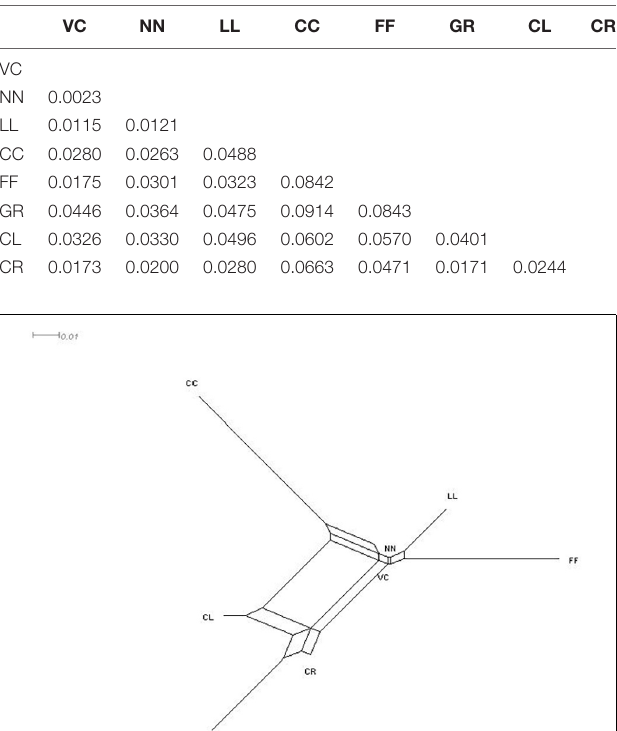
TABLE 6 | Analysis of molecular variance (AMOVA) based on 20 microsatellite loci of five populations (villages) assigned into two groups (two sites). Sources of variation df Percentage of Between sites 0.34